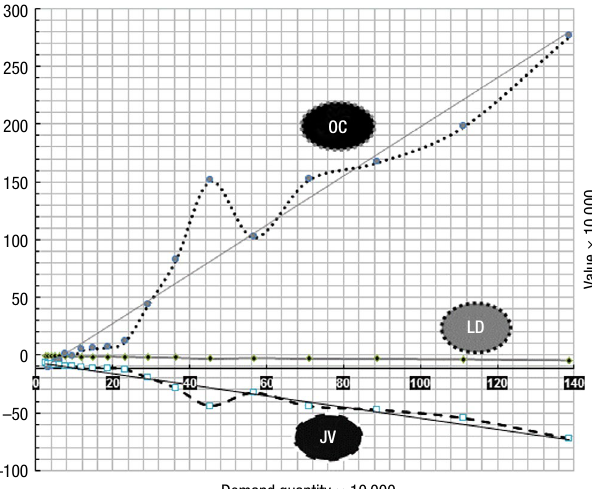
Fig. 1. Simulation of different options for entering in a FM, considering different demand quantity